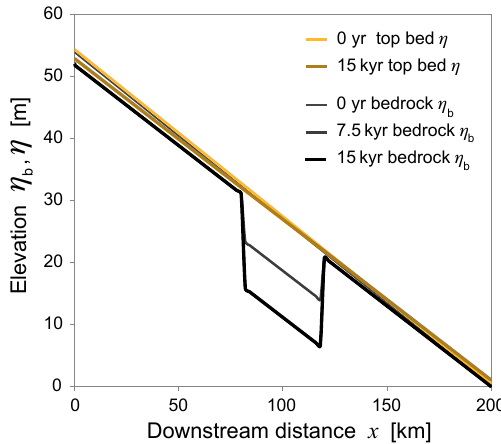
Figure 14. Evolution predicted by the MRSAA model for localized subsidence at a narrow graben superimposed on broader uplift. Note the bedrock–alluvial and alluvial–bedrock transitions at the margins of the graben. By 15kyr, the bed top has reached steady state, even though the bedrock surface in the graben continues to subside. The regional rock uplift rate and graben subsidence rate are assumed constant for simplicity. Here η denotes elevation at the bed top, η b denotes elevation of the bottom of bedrock relief, and x denotes streamwise distance.